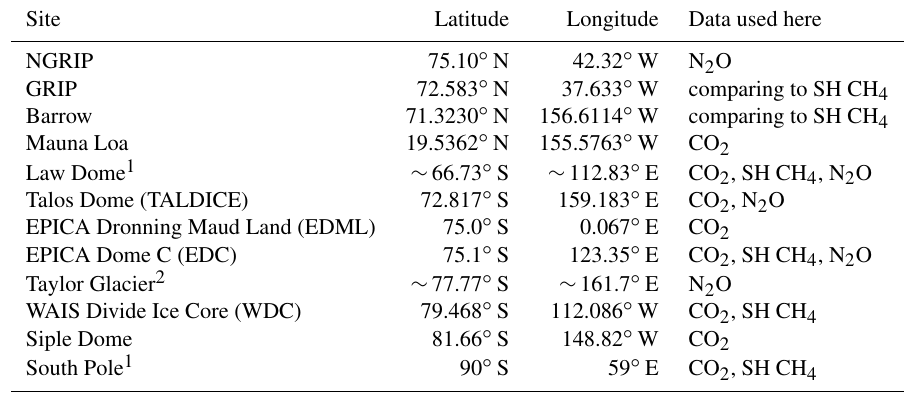
Table 1. Locations of the different data sources, ordered north to south. Individual sites of the NOAA observational network are not explicitly mentioned here, when they only contribute to global mean calculations. SH CH 4 : Southern Hemisphere CH 4 .